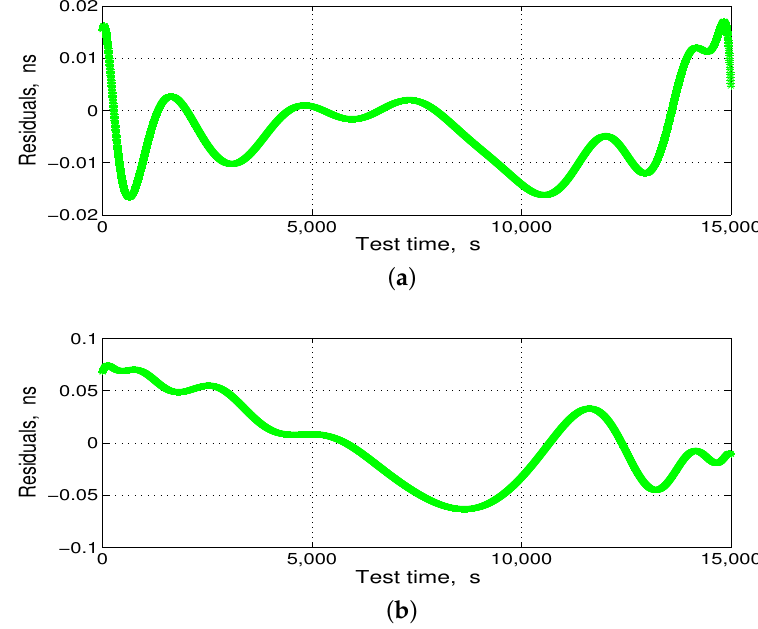
Figure 13. Delay residuals after compensation in the temperature-change test; ( a ) transmission-delay residuals; and ( b ) reception-delay